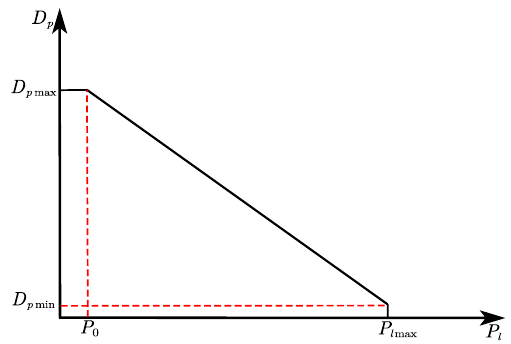
Figure 6. Relationship between displacement and load pressure for DLS-EHA.